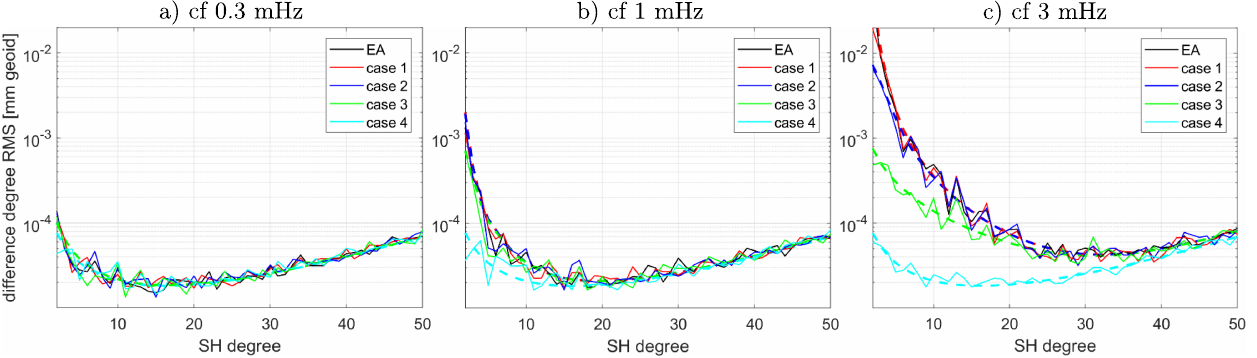
Figure 12. Degree RMS of residual coefficients for a Bender-type mission under consideration of the static gravity field signal and a hybrid accelerometer with a 1/ f 3 EA noise slope for an EA corner frequency ( a ) of 0.3 mHz, ( b ) of 1 mHz, and ( c ) of 3 mHz. The respective formal errors are shown as dashed lines of the corresponding